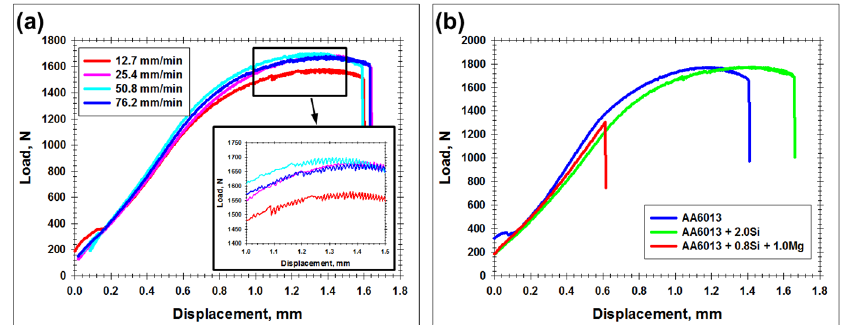
Figure 7. Typical effect of welding speed ( a ) and impurity content in aluminum alloy ( b ) on tensile behavior of welded joints. In ( a ), tensile diagrams for AA6013 + 2.0 Si alloy are shown. In ( b ), welded joints were produced at welding rate of 76.2 mm/min. Note: The high-magnification insert in the bottom-right corner of ( a ) illustrates Portevin–Le Chatelier effect.